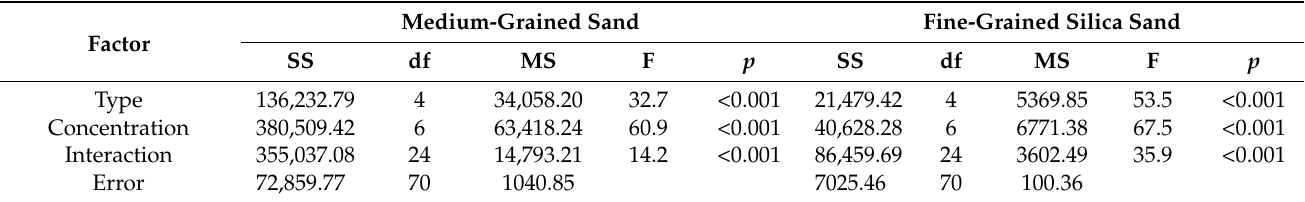
Table 3. Results of two-way ANOVA ( α = 0.05) of wind tunnel test data from Phase 1, investigating the effect of the concentration on the wind-induced soil loss.